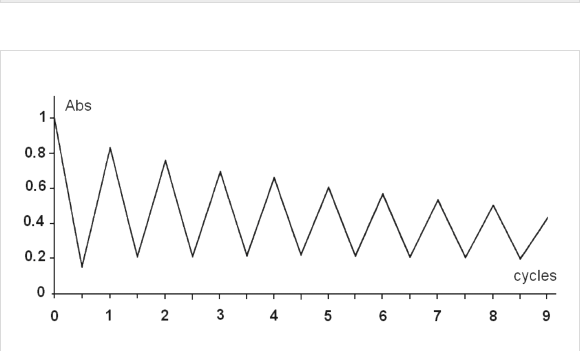
Figure 8: Irradiation at 306 nm of the photoproduct 4 obtained at 400 nm in the same setup; the spectra were recorded at various time inter- vals, within 10 min, at ambient temperature.